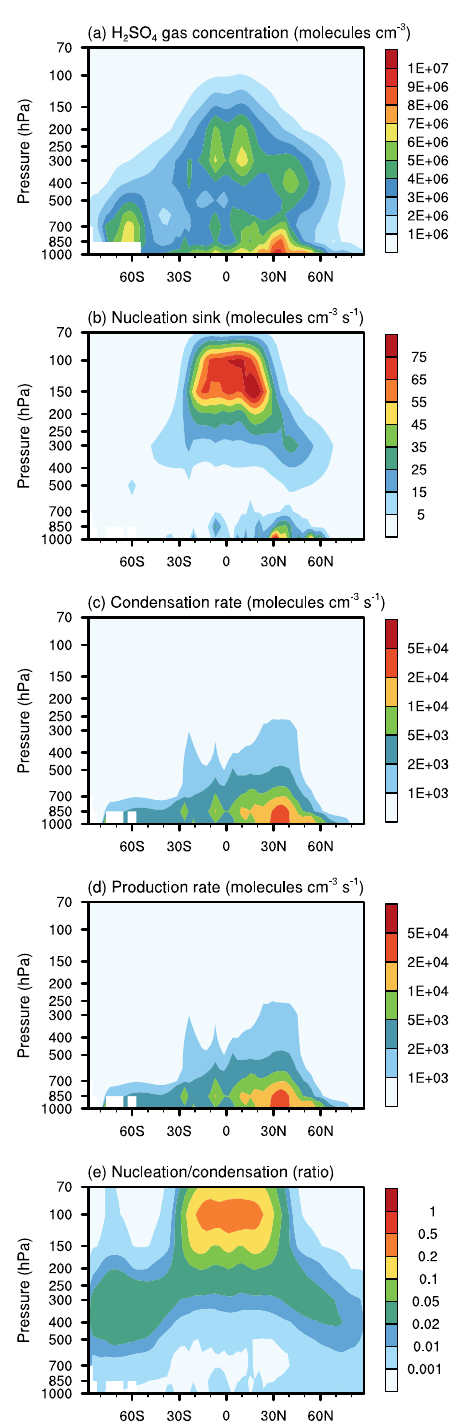
Fig. 3. Zonally and annually averaged vertical cross sections of the H 2 SO 4 gas (a) concentration, (b) loss rate due to aerosol nu- cleation, (c) condensation rate, (d) production rate, in the reference solution established in Sect. 3. Panel (e) shows the ratio between the nucleation sink and the condensation